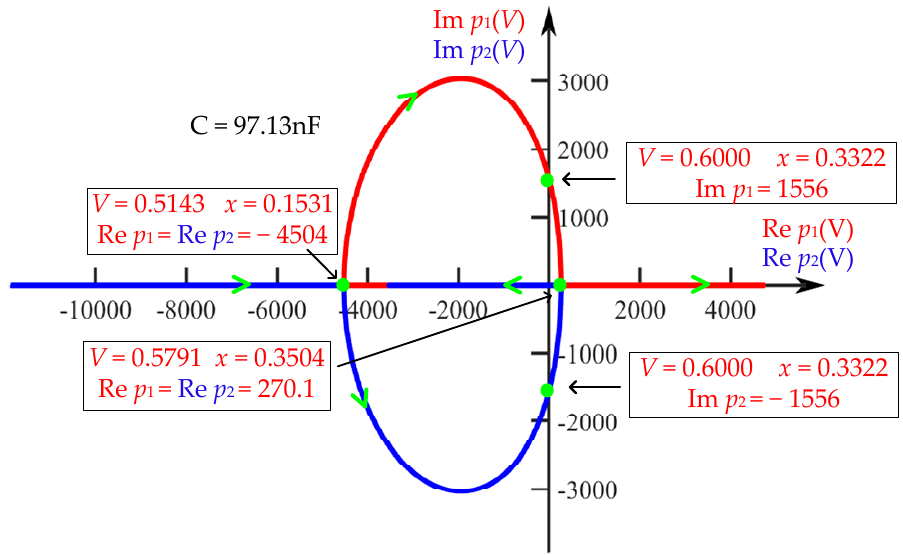
Figure 11. Variation in the real and imaginary parts of the poles of the admittance function in the oscillation circuit with the DC voltage (if C = 97.13 nF). From Figures 11 and 12, we find that the Hopf bifurcation frequency ω H = 1556 rad/s and the system oscillation frequency ω C = 2 π /4.000 ms = 1570 rad/s through numerical calculation. It follows that ω C is consistent with the expected oscillation frequency ω H .